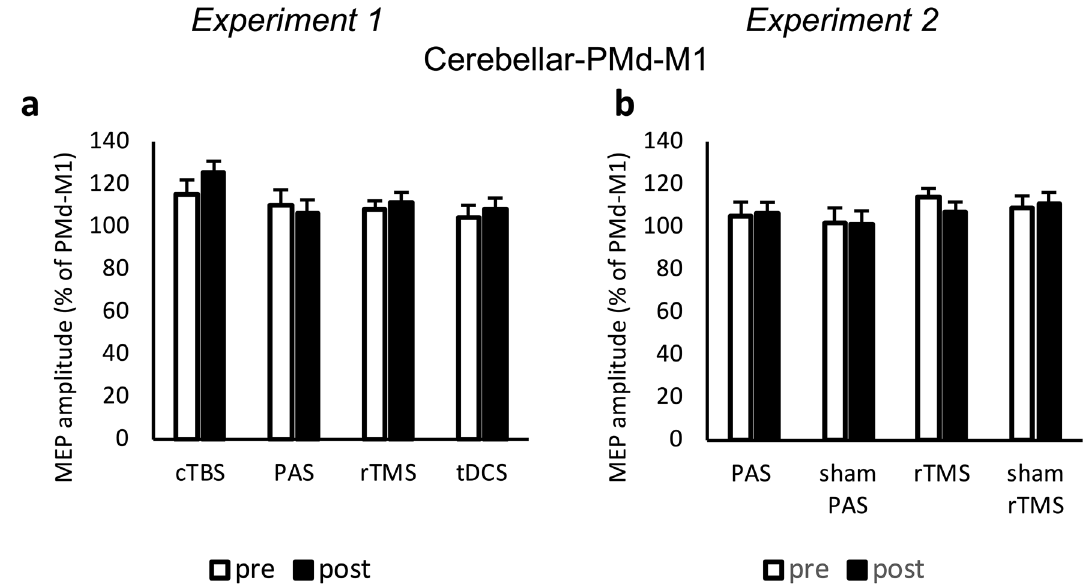
Figure 5. Analysis of triple-pulse TMS (experiments 1 and 2). MEP amplitudes were measured peak-to- peak and indicated in percentage to the MEP generated due to premotor cortex (PMd)-M1 interaction. Both PMd and cerebellar conditioning pulses were given in addition to M1 stimulation within the triple-pulse paradigm. Error bars indicate standard error of mean. ( a and b ) There was no significant change after any of the interventions. MEP motor evoked potential, TP test pulse over primary motor cortex, PMd dorsal premotor cortex, M1 primary motor cortex, PAS paired associative stimulation, rTMS repetitive transcranial magnetic stimulation, cTBS continuous theta-burst, tDCS transcranial direct current stimulation, ISI interstimulus